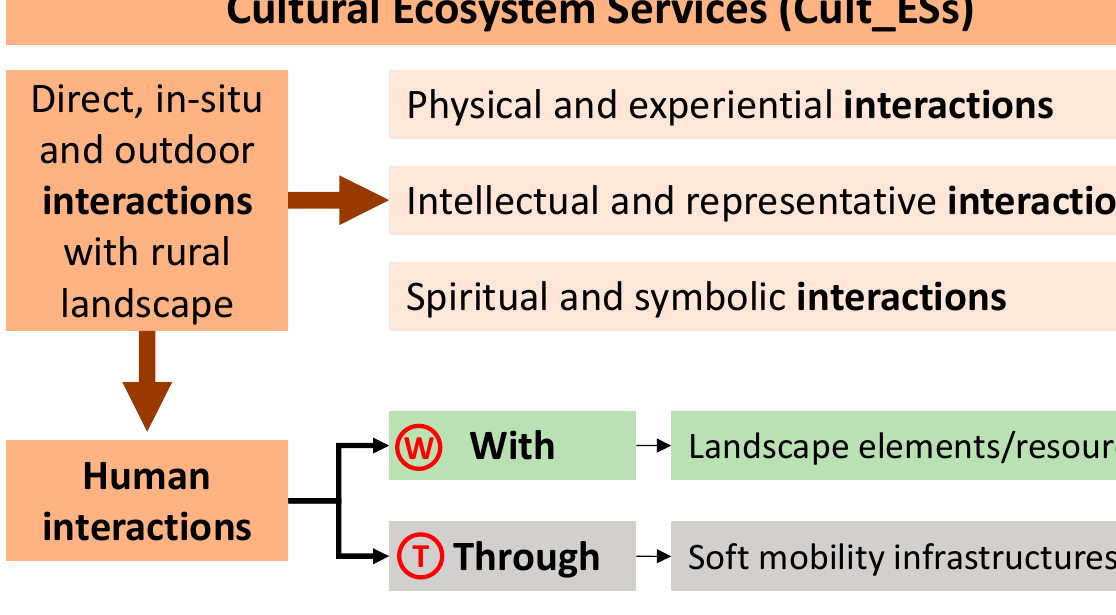
Figure 1. Conceptual framework of the planning goal for the enhancement of the cultural ecosystem services provided by the rural landscape (adapted by authors from CICES V. 5.1).